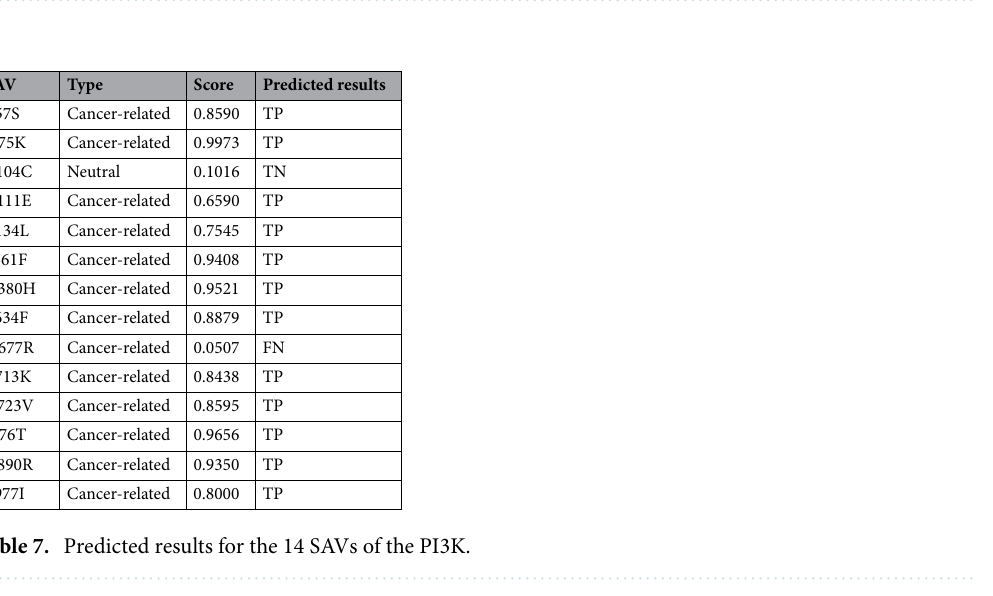
Figure 3. Protein structures of the PI3K/p85 α complex. The PI3K (wheat color) and p85 α (gray color) complex (PDB ID: 5DXU) in the cartoon is drawn by PyMOL 100 . ARG104 (illustrated by the green spheres) is a neutral SAV that mutates to CYS. The other residues shown in the pink spheres are all cancer-related SAVs.